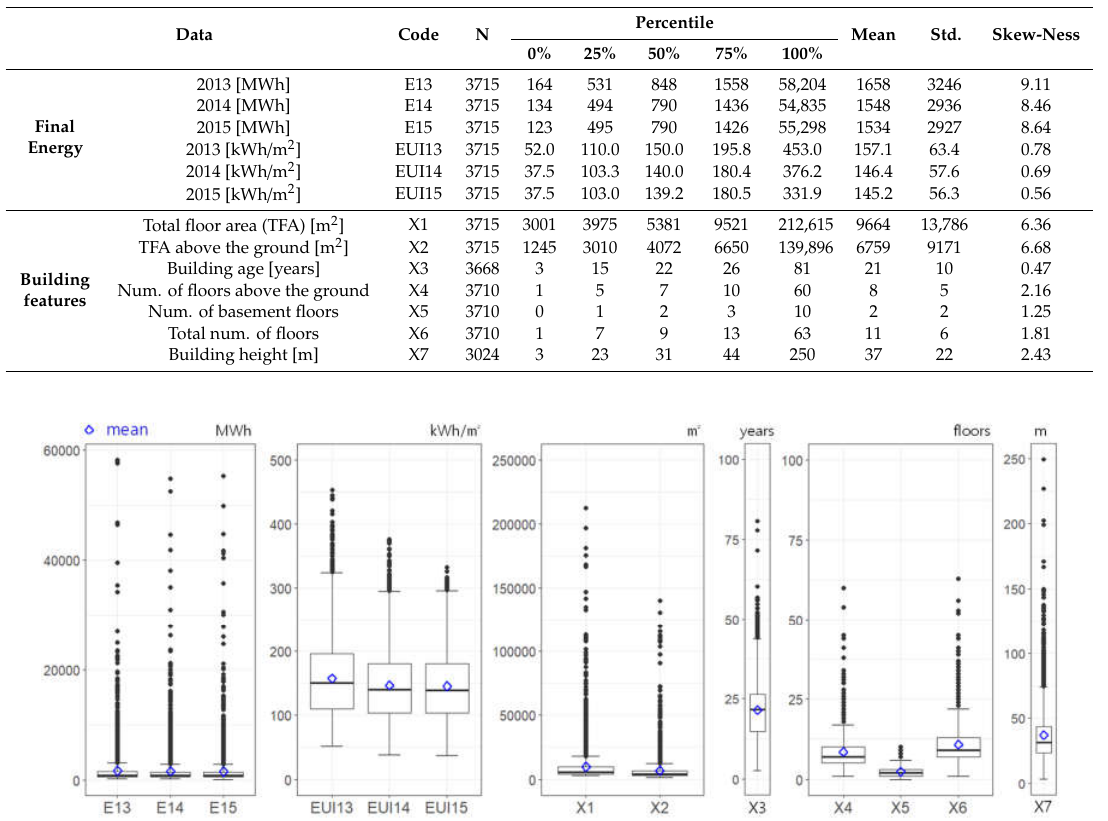
Figure 1. Distribution of collected office building data in Korea.